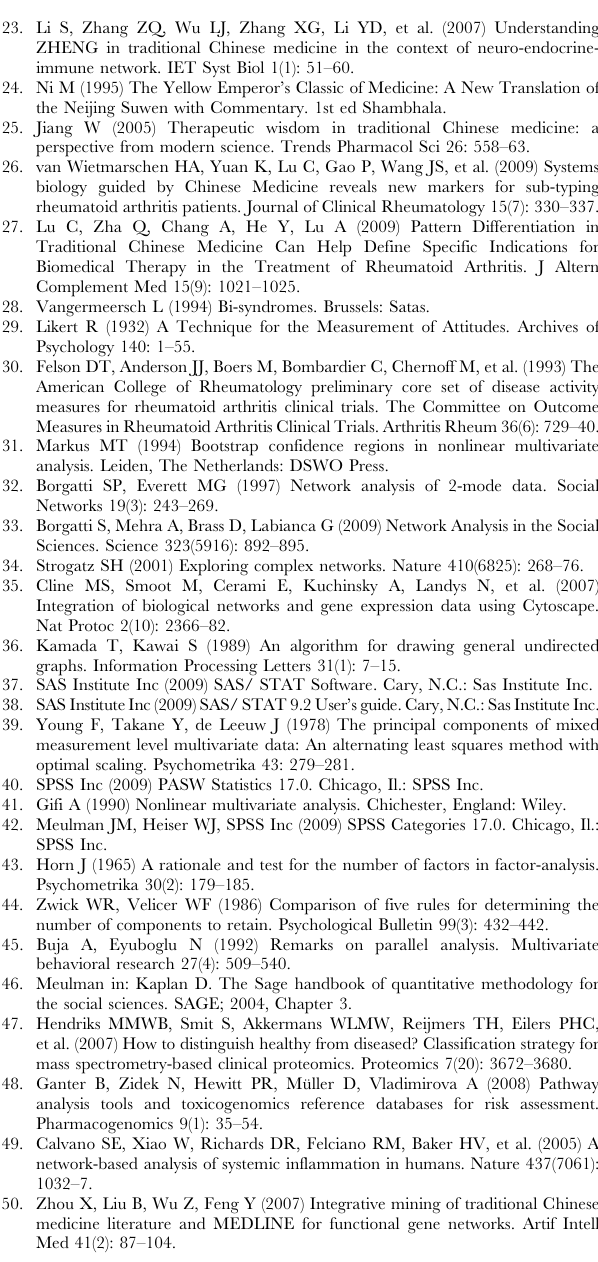
Table S1 VAF table for the analysis presented in Figure 3.